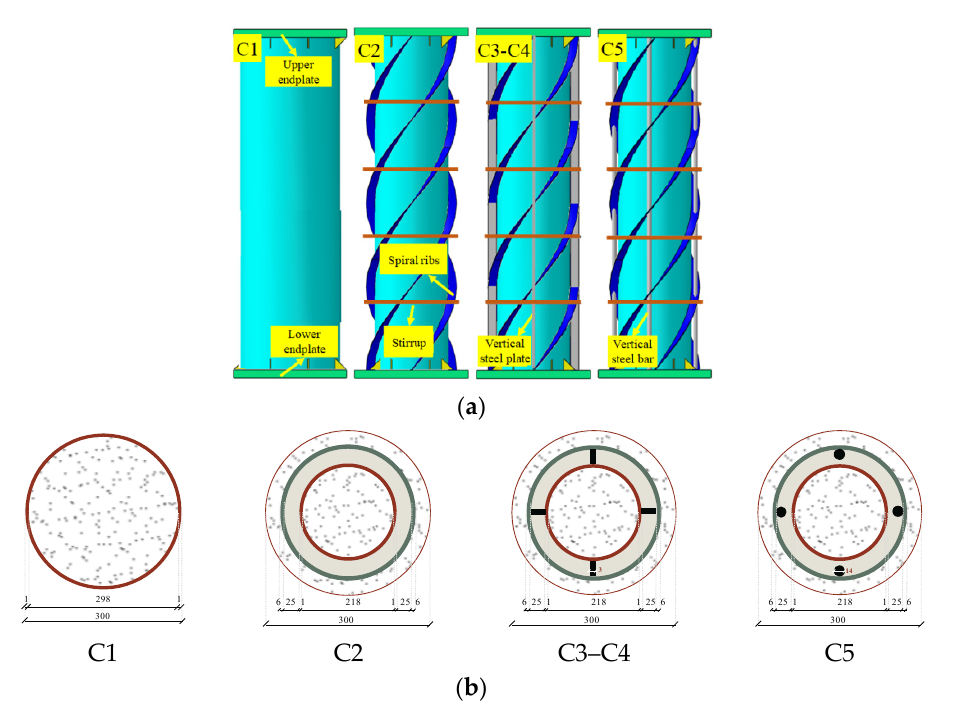
Figure 1. Specimen shape. ( a ) Schematic diagram ( b ) Cross-section form. Table 1. Parameters of the specimens.